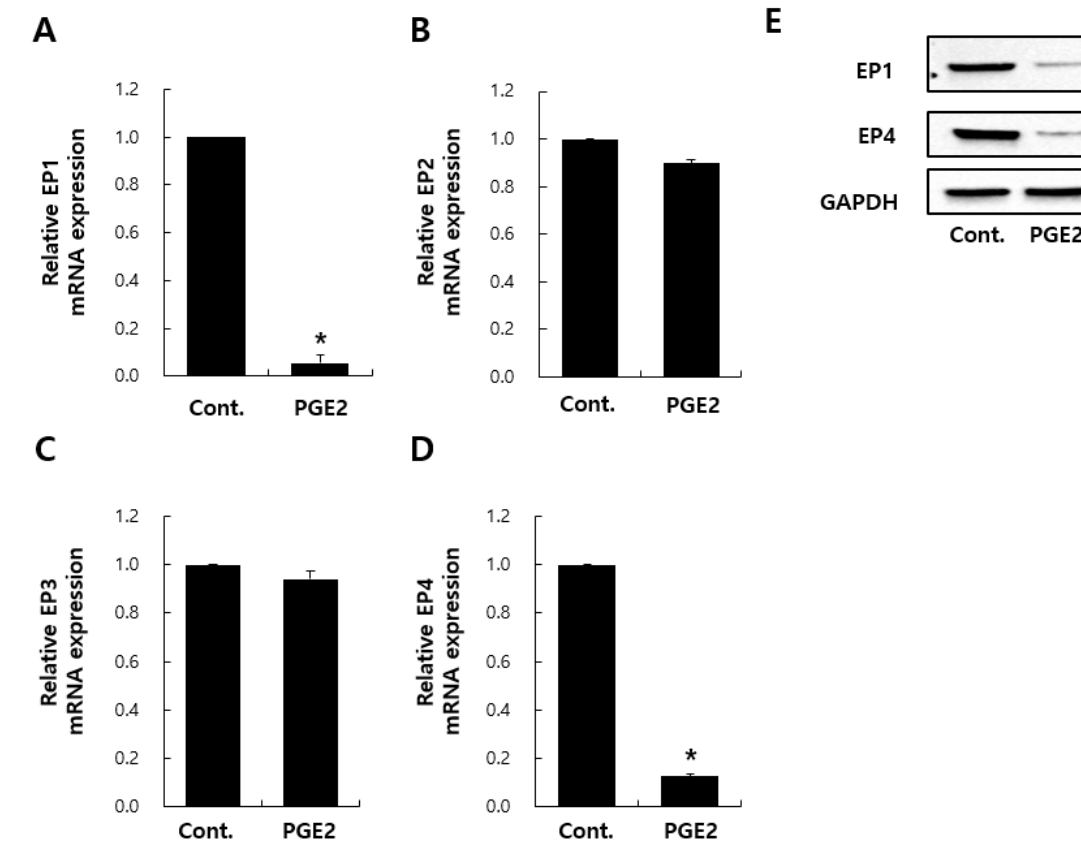
Figure 3. Analysis of transcript levels of different receptors E-prostanoid 1–4 (EP1–EP4) after PGE2 treatment. Transcriptional expression of PGE2 receptors (EP1–EP4) by NHDFs after 24 h treatment with DMSO or PGE2 ( A – D ). Immunoblotting analysis for EP1 and EP4 ( E ). Values represent the mean ± SD of three independent experiments. * p < 0.05 compared to the control.